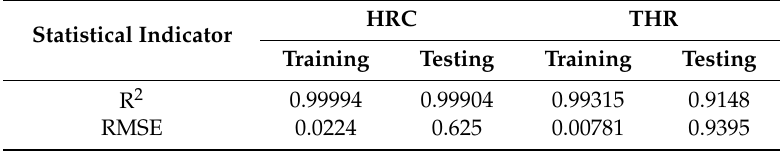
Table 8. Performance of ANFIS models.